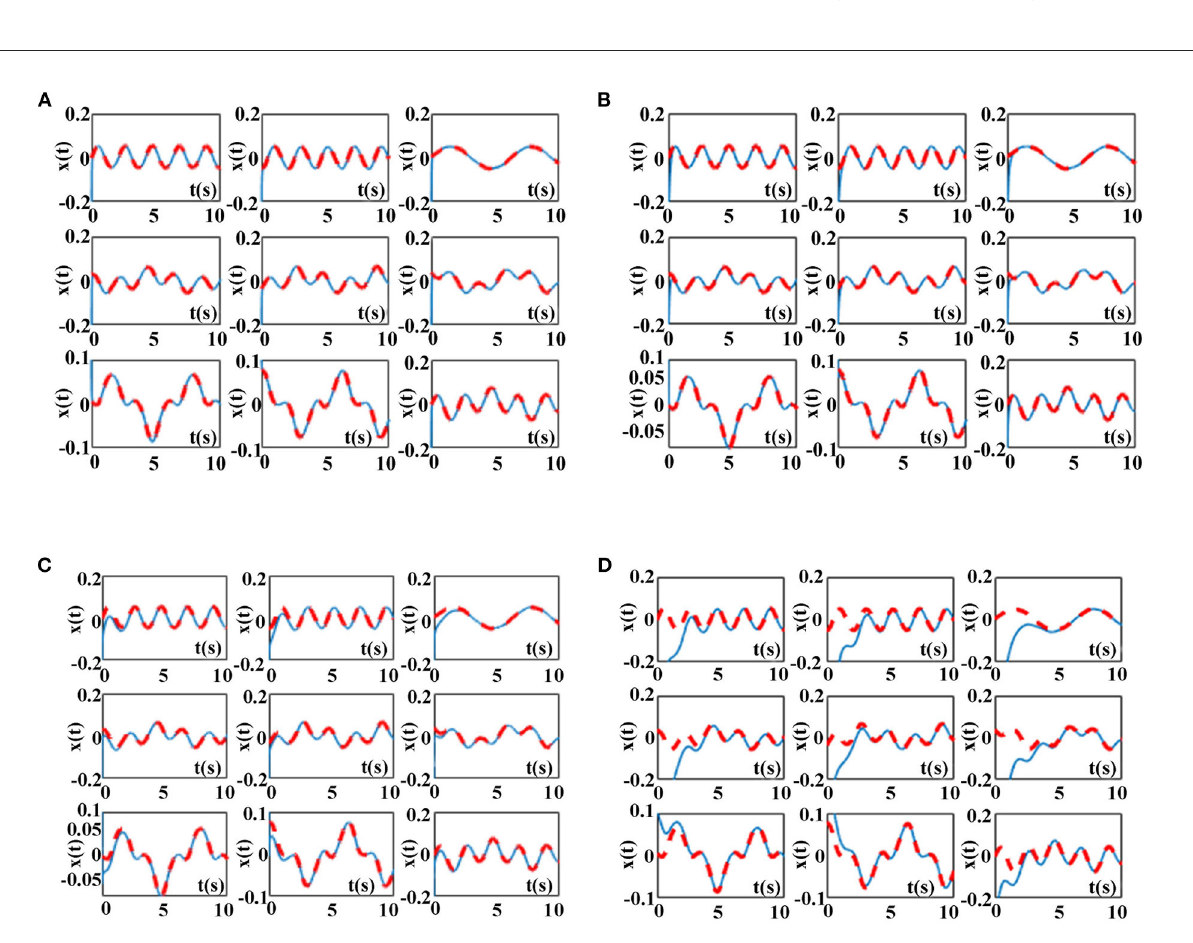
FIGURE12 TODSE (5) solved by ZNN model (9) and the proposed NAF-based FTCRNN model (11) without noise. (A) Solved by FTCRNN model (11) without noise. (B) Solved by VAF-based ZNN model (9) without noise. (C) Solved by SBPAF-based ZNN model (9) without noise. (D) Solved by LAF-based ZNN model (9) without